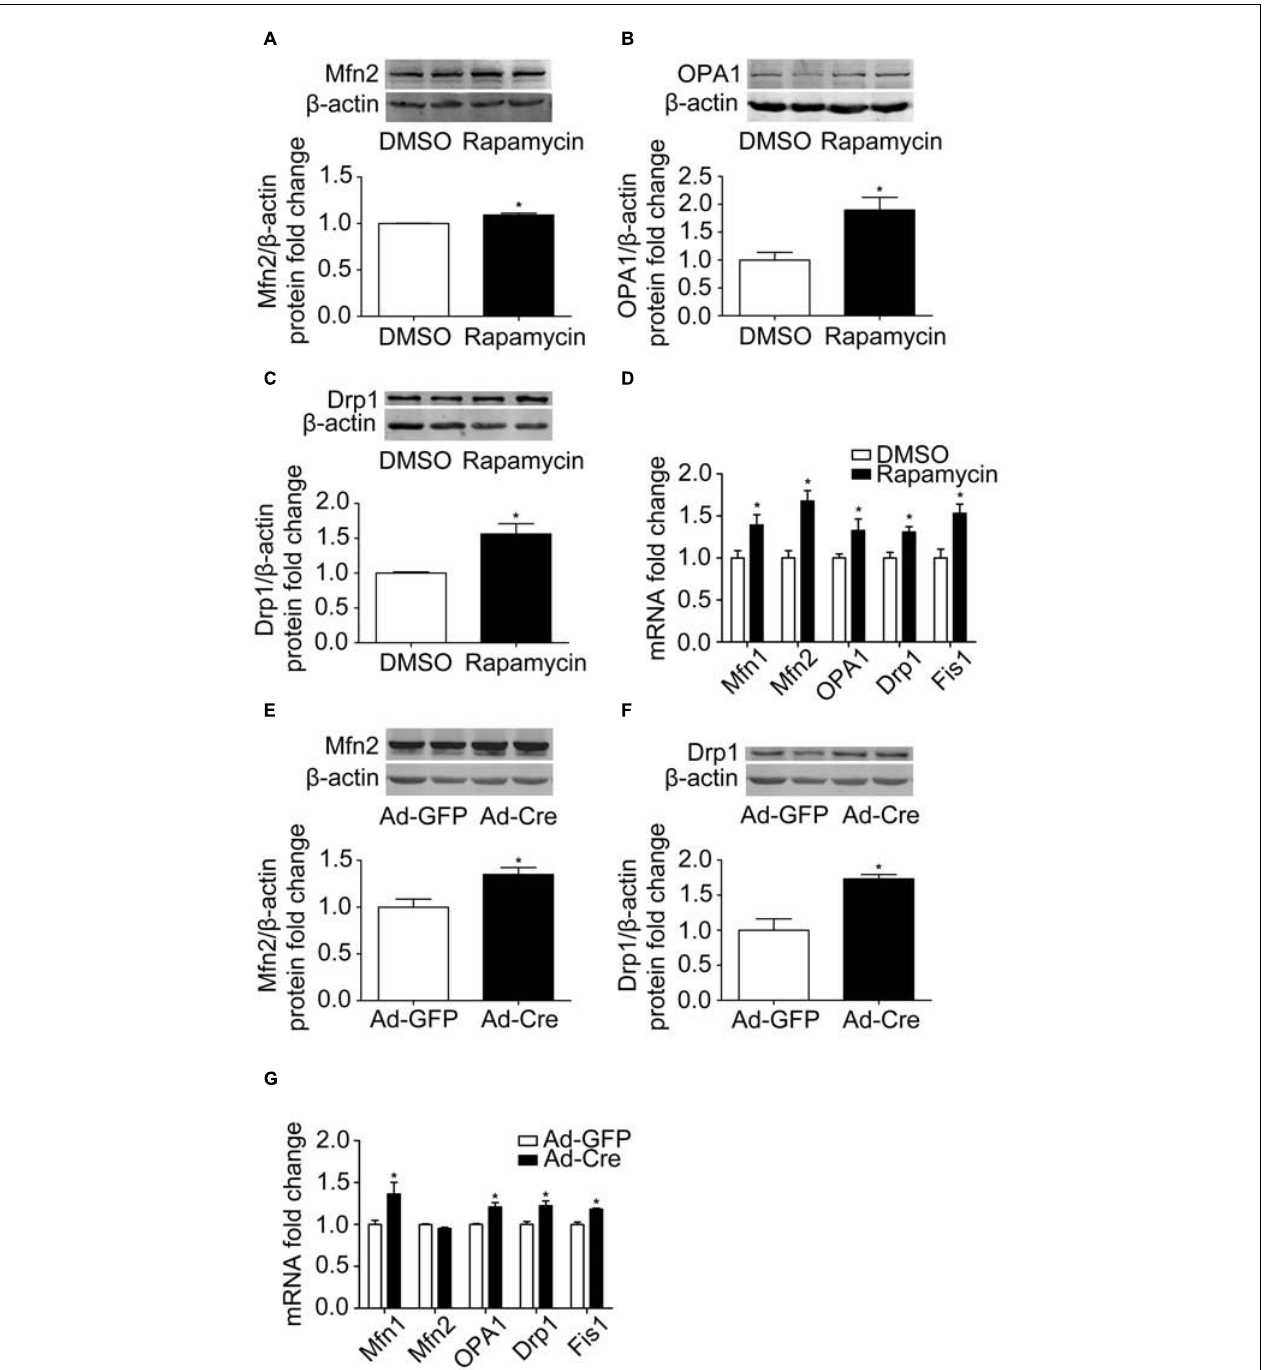
FIGURE 4 | Inhibition of mTOR promotes mitochondrial dynamics of brown adipocytes. (A–C) Primary brown adipocytes were isolated from neonatal C57BL/6J mice and cultured for differentiation. Proteins were extracted after 6 days of differentiation. Western blotting of Mfn2, OPA1, and Drp1 was performed with β -actin as a loading control. Relative protein signal intensity was quantified and expressed as means ± SD. (D) Total RNAs were extracted after 6 days of differentiation. Real-time PCR was performed to evaluate the expression of mitochondrial dynamics marker genes with β -actin as a loading control and results expressed as means ± SD. *Denotes P < 0.05 relative to control. (E,F) mTOR loxp / loxp brown adipocytes were treated with Cre adenoviruses for 48 h and controls with GFP adenoviruses. RNAs and protein were extracted as described in the methods section and results shown are representative of western blots for Mfn2 and Drp1. β -Actin was used as the loading control. Relative protein signal intensity was quantified and expressed as means ± SD. (G) Real-time PCR was performed to evaluate the expression of genes related to mitochondrial dynamics. Levels of mRNA expression were normalized to β -actin and expressed as means ± SD. * P < 0.05 vs.